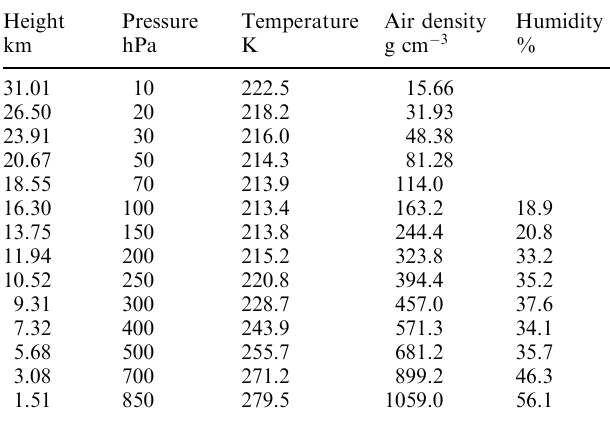
Table 10. Radiosonde values over southern Germany in the month of October, averages from 1981 to 1985